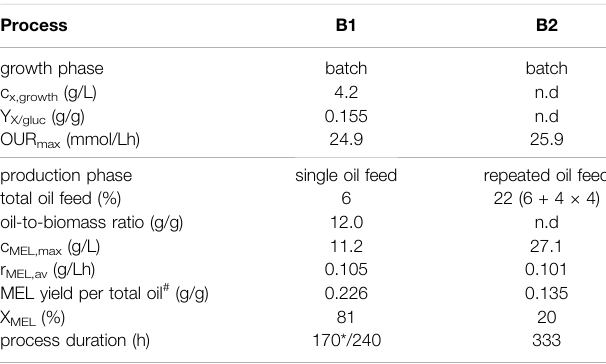
TABLE 2 | Process values for fermentations with batch growth and single or repeated oil feeding. Process